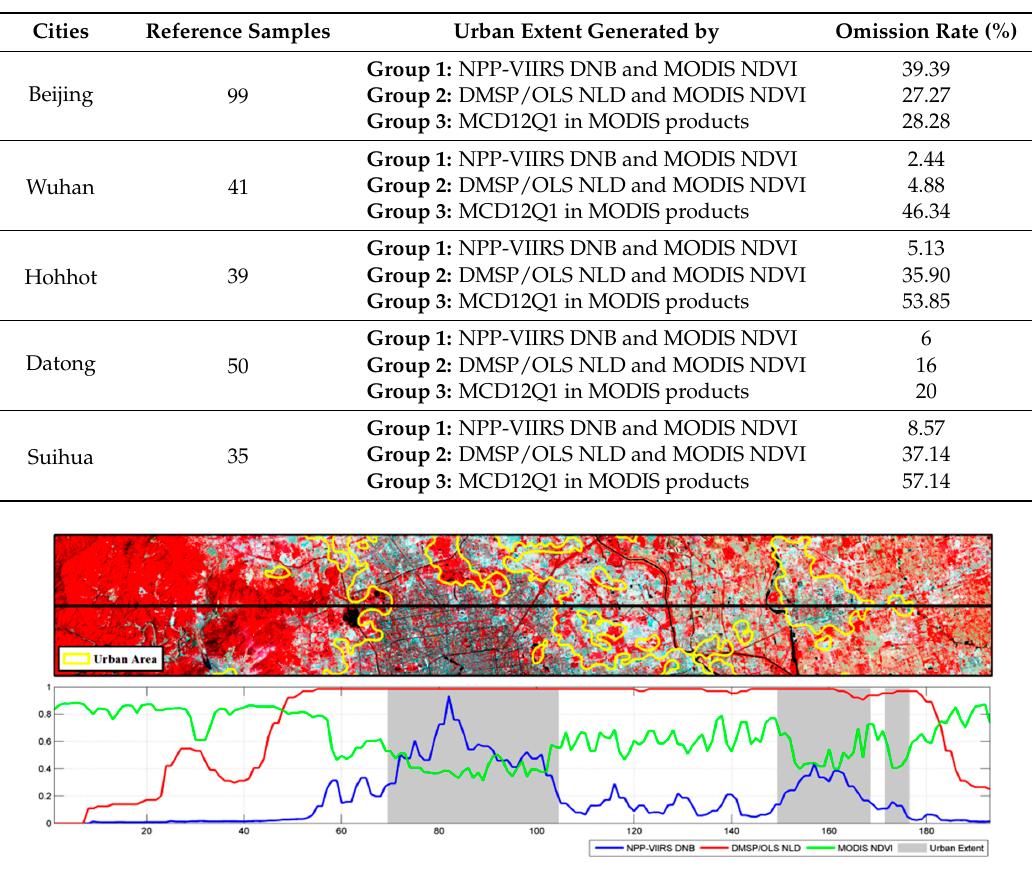
Table 4. The urban omission rate of five cities (Beijing, Wuhan, Hohhot, Datong and Suihua) in different productions.